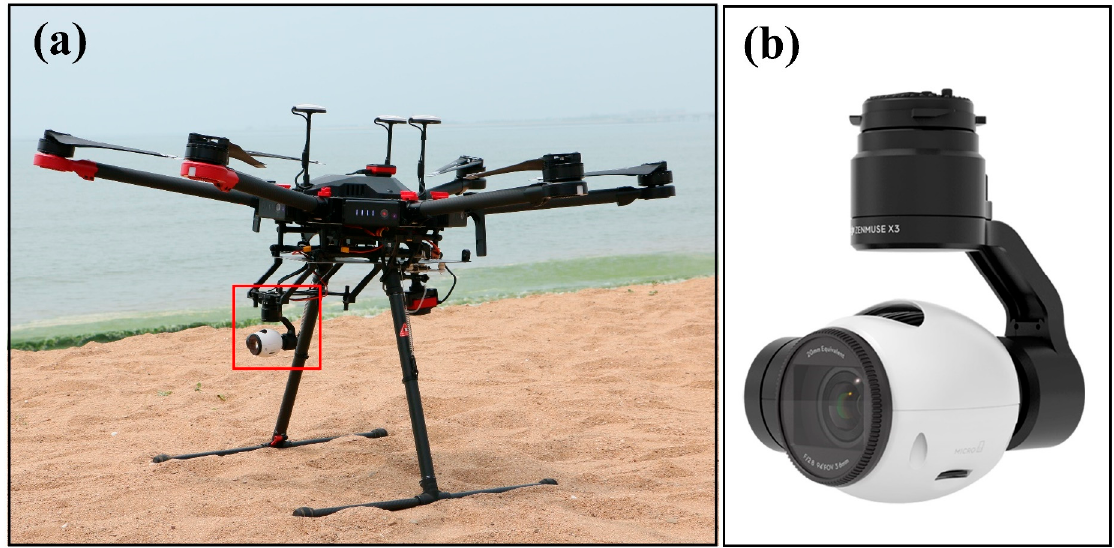
Figure 2. ( a ) Picture of MATRICE M600 Pro UAV; and ( b ) DJI Zenmuse X3 RGB